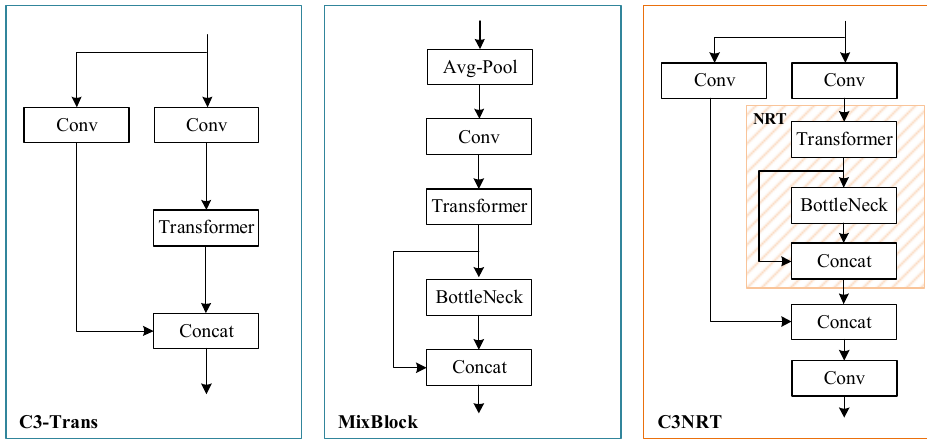
Figure 5. The comparation between C3NRT and other structures.